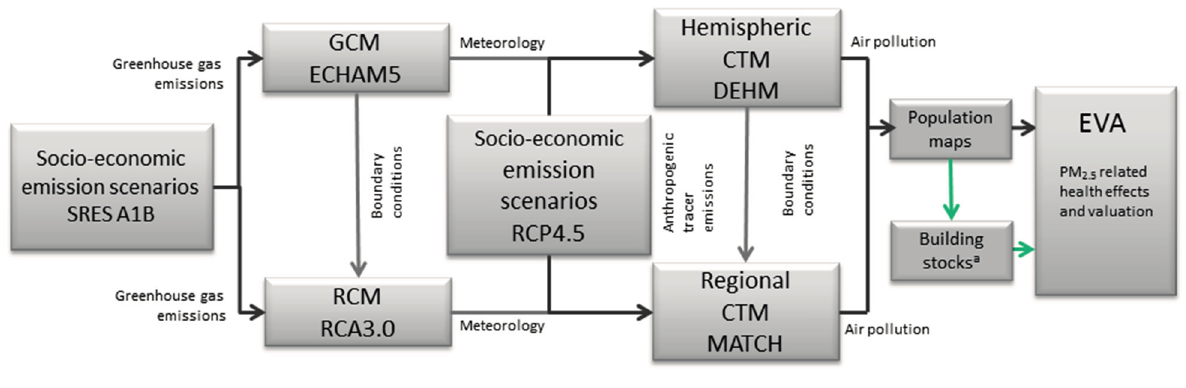
Figure 1. An illustration of the model chain and the required input data. The green arrows indicate the new terms related to the building stocks and infiltration. a Tentatively accounted for here—for the first time in relation to climate change exposure